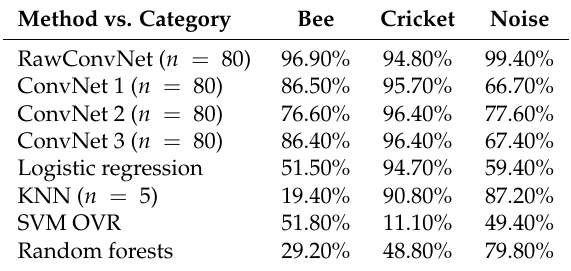
Table 25. Classification accuracy summary on BUZZ2 validation dataset by